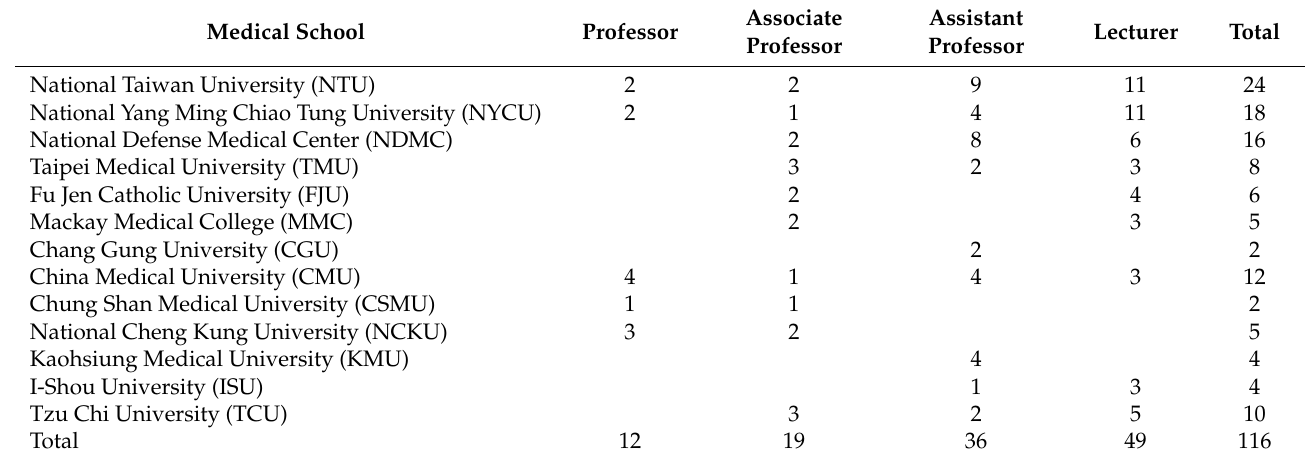
Table 1. Family medicine teachers at the 13 medical schools in Taiwan (2019).